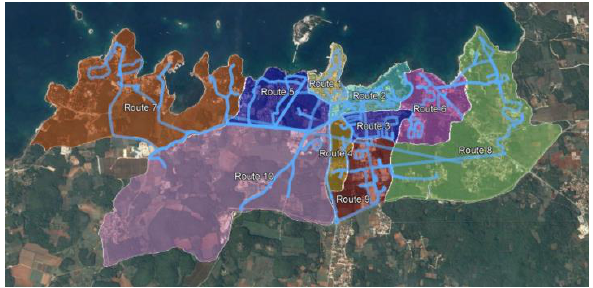
Figure 3. The followed biological recording routes inside 10 sub-areas (coloured) of the City of Poreč. Route numeration corresponds to Table 1.